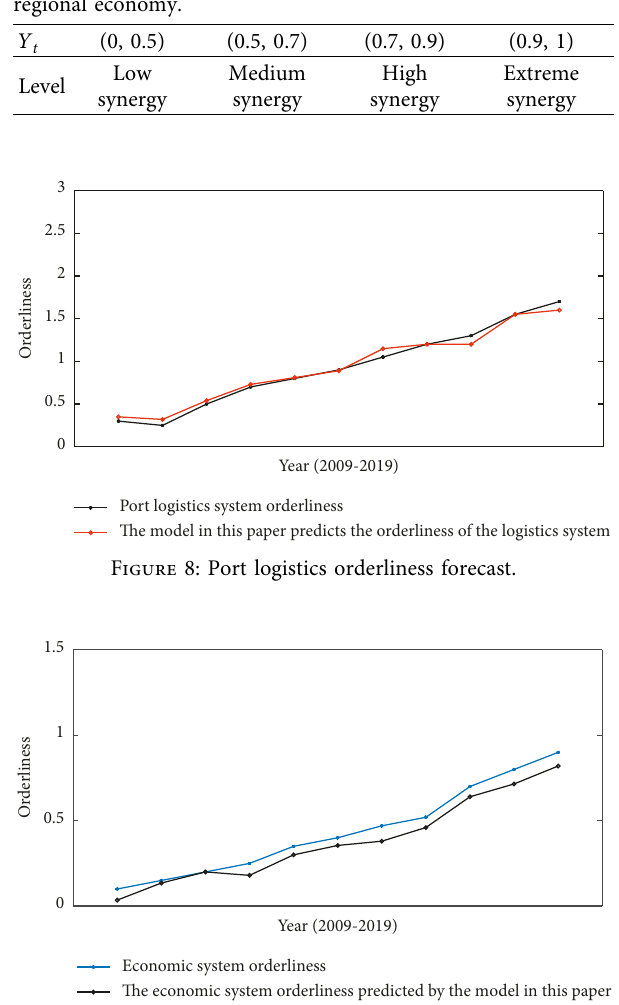
Figure 9: Economic orderliness of the hinterland city where the port is located.